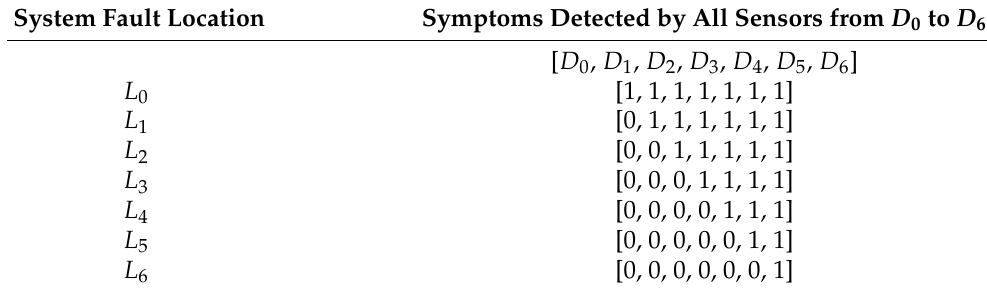
Table 2. Fault-symptom table of a seven-layer cloud system used for the fault detection method. System Fault Location